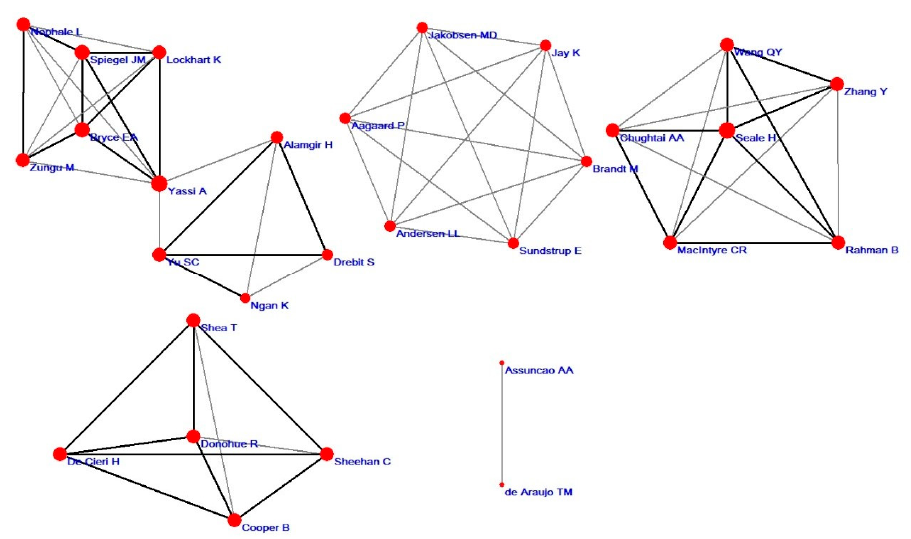
Figure 4. The top 20 most productive authors collaboration network.